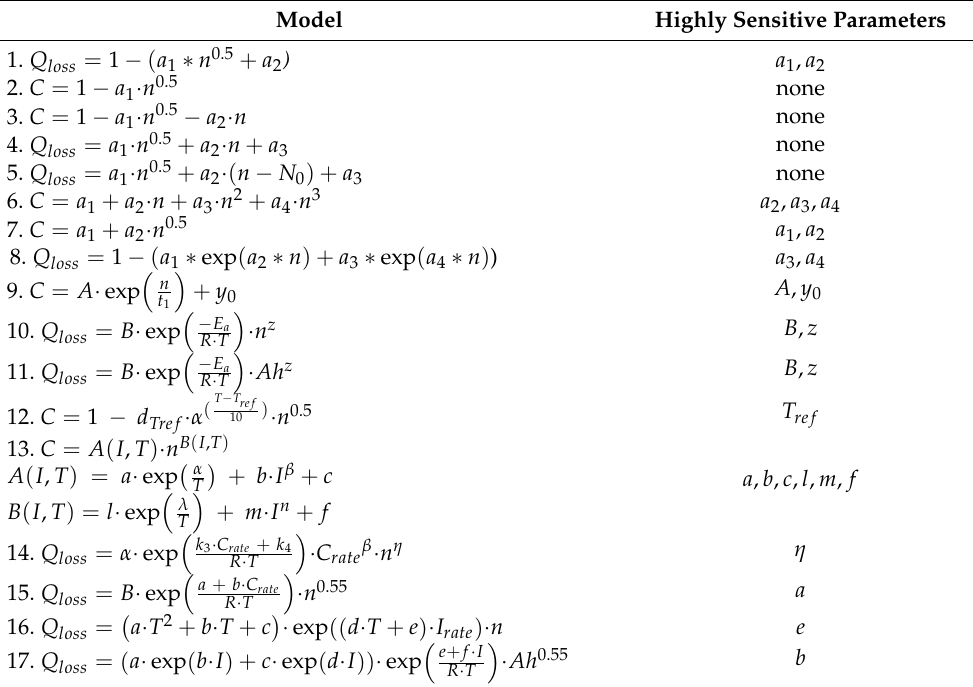
Table 6. Highly sensitive parameters in the empirical model parameters by MPSA analysis. Model Highly Sensitive Parameters